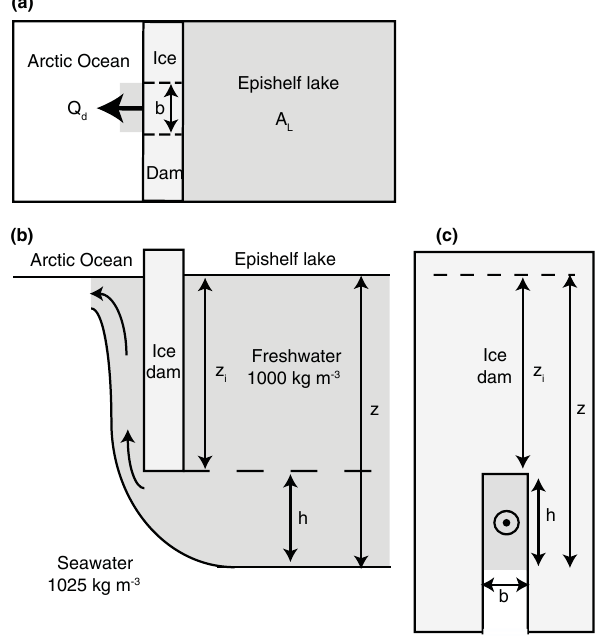
Figure 10. Schematic representation of epishelf lake outflow through a basal channel in the ice shelf dam in (a) plan, (b) ele- vation, and (c) cross-sectional views. The volumetric discharge is modelled using a modified form of the rectangular weir equation (Eq.